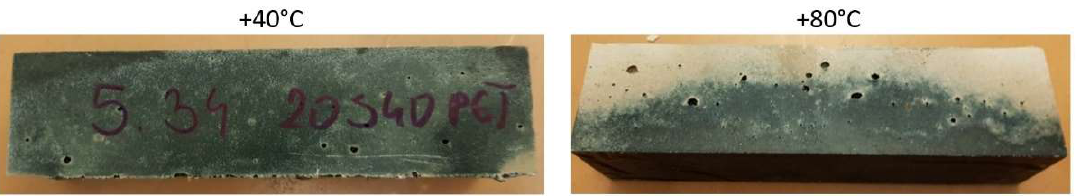
Figure 2. Specimens with 20% activator cured at 40 °C or 80 °C for 12